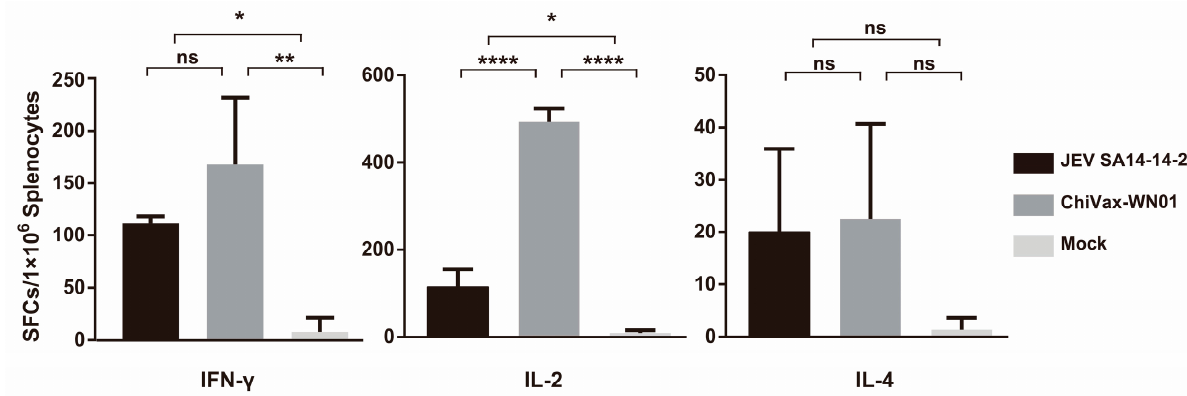
Figure 6. ELISpot analysis of splenocytes secreting IFN- γ , IL-2, and IL-4 from the immunized mice. Four-week-old female BALB/c mice ( n = 3) were inoculated with JEV SA14-14-2 or ChiVax-WN01 at 100 PFU i.p. Mice splenocytes were collected after 15 weeks post inoculation and were restimulated with ChiVax-WN01 or E80 (10 μ g/mL). The splenocytes secreting the IFN- γ , IL-2, and IL-4 were quantified according to the ELISpot assay. Data shown are as the means ± SD and were analyzed by one-way ANOVA (* p < 0.05; ** p < 0.01; **** p < 0.0001). ns indicates no significance.